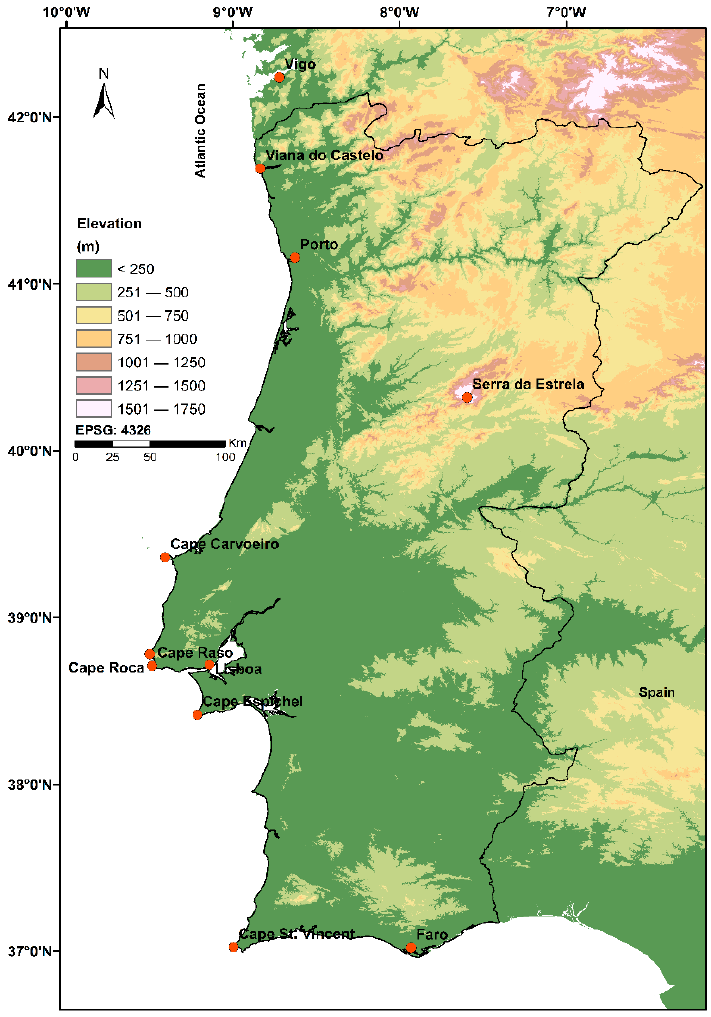
Figure 1. Hypsometric chart of Portugal. The different colours represent the terrain elevation (m). Key locations for this study are marked by red circles.